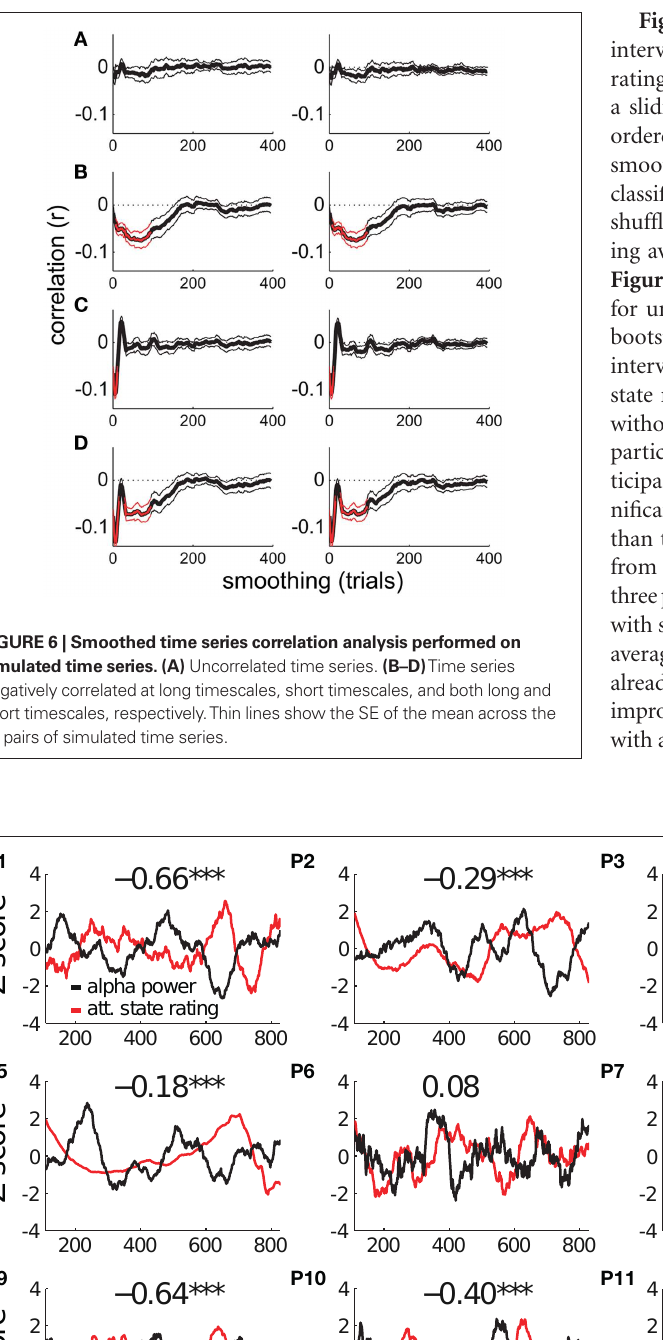
individually (P1–P12). The correlation coefficient ( r ) between the two time series for each participant is shown at the top of each plot. Significant correlations are indicated by a star. Triple starred correlations are significant at p <